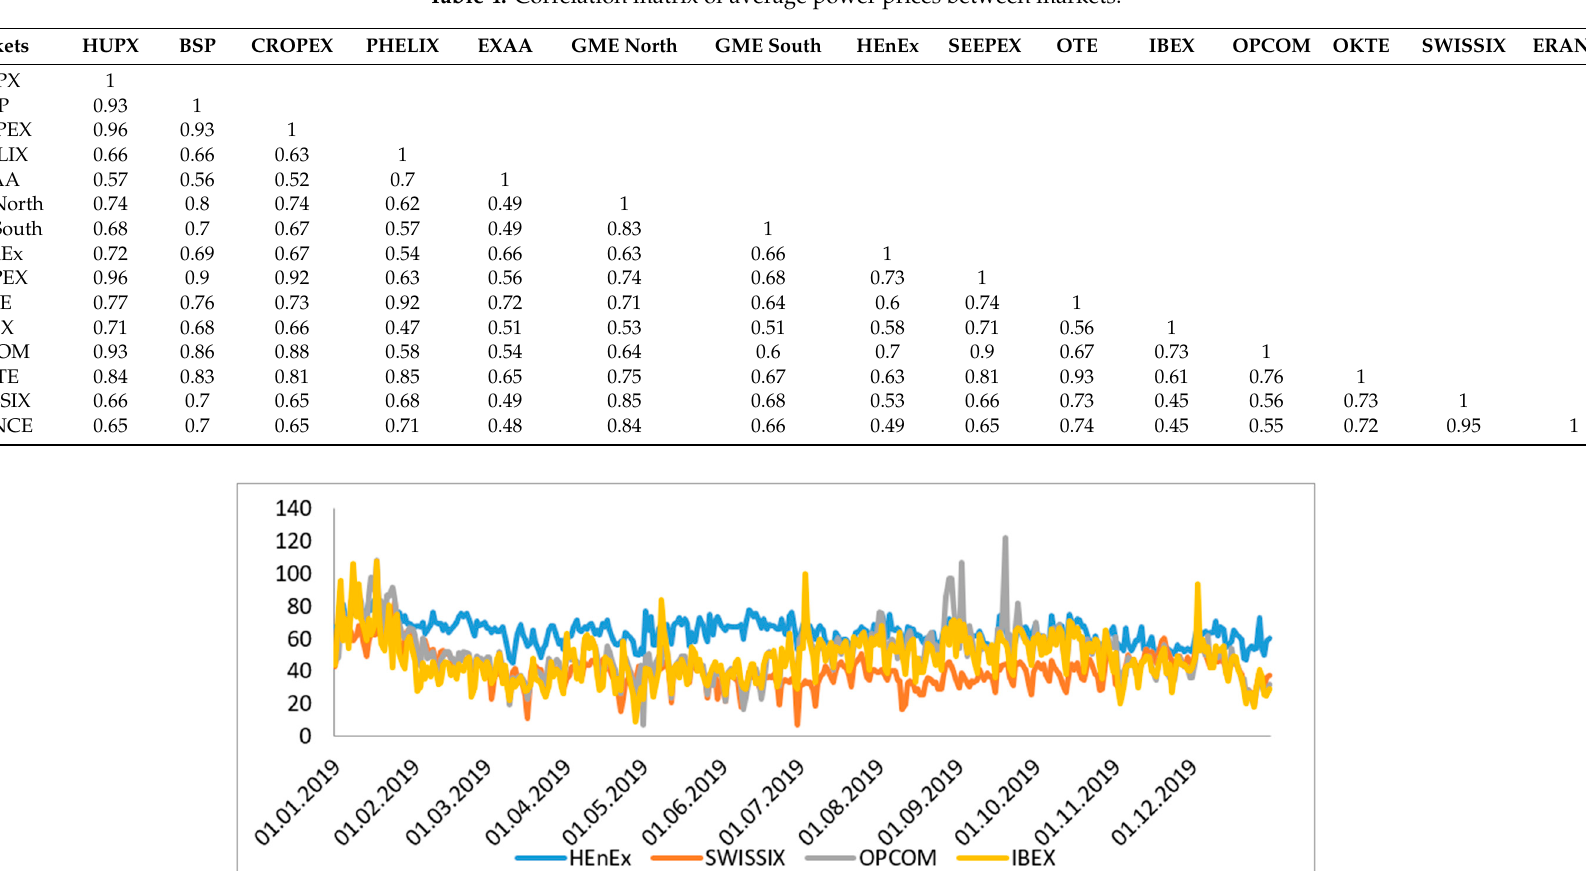
Figure 2. Average hourly prices in 2019.